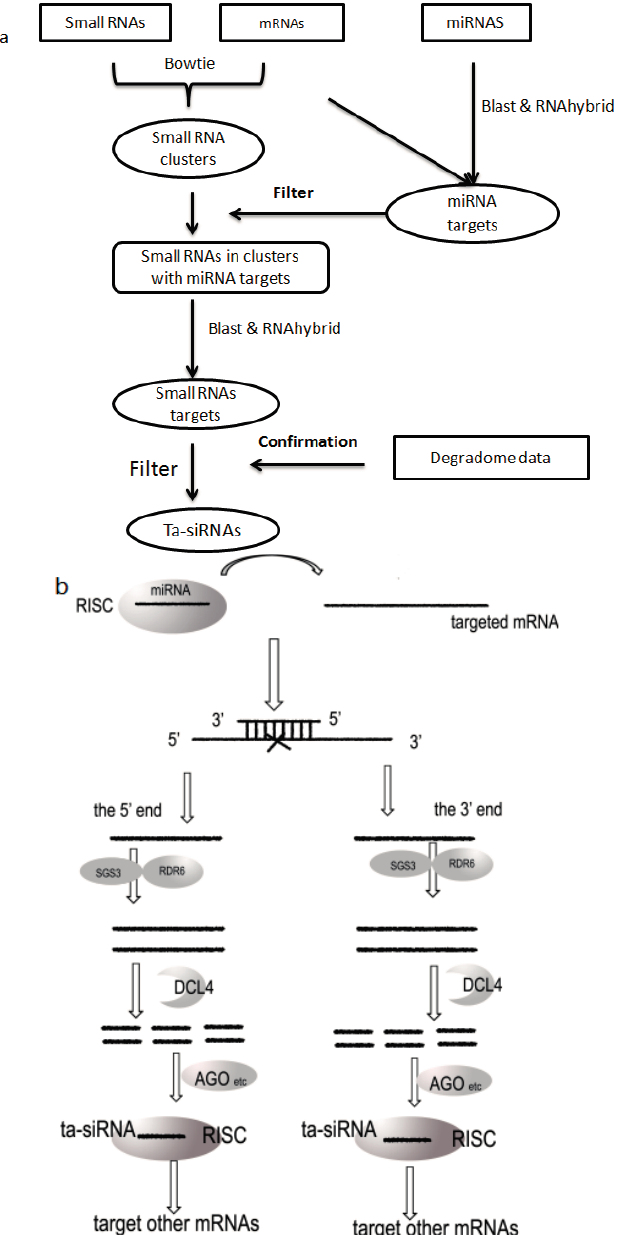
Figure 2. ( a ) Schematic of our ta-siRNA prediction pipeline; ( b ) Generation of